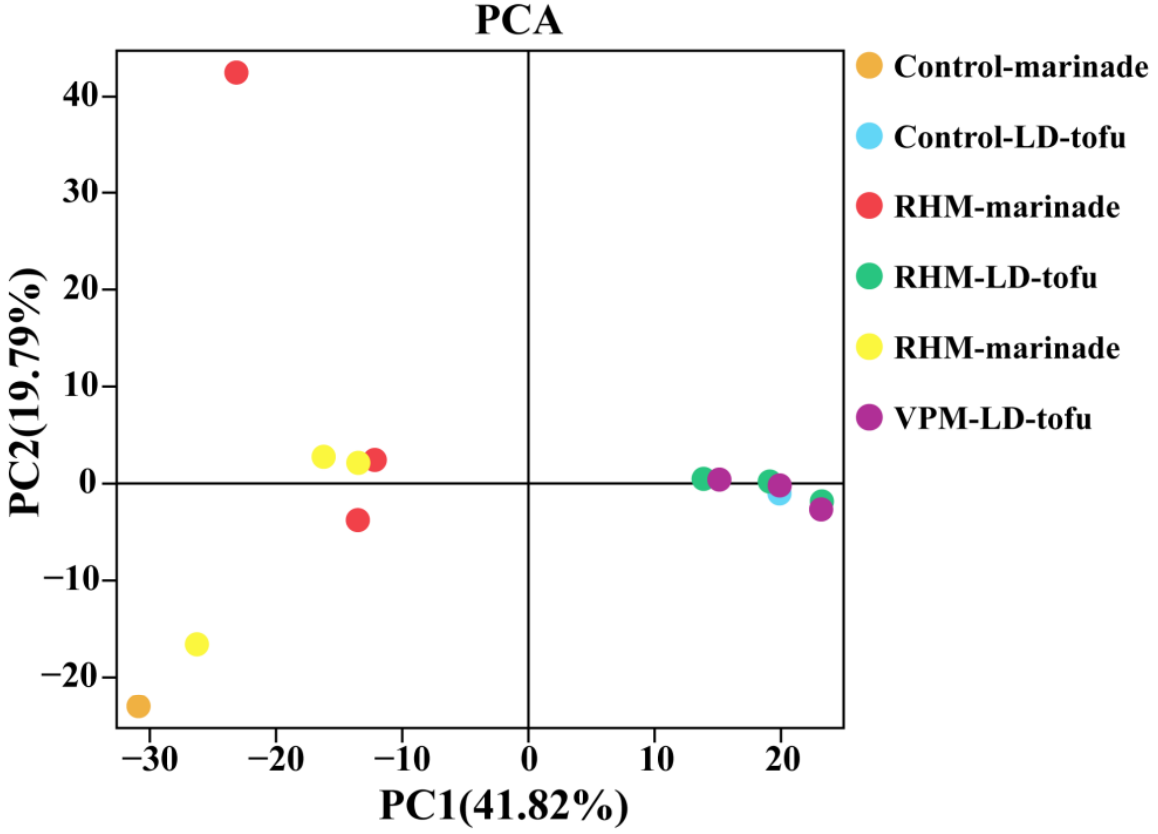
Figure 4. Principal component analysis of the effects of marinating methods and marinade recycling cycles on the microbial β -diversity of LD-tofu and marinade.